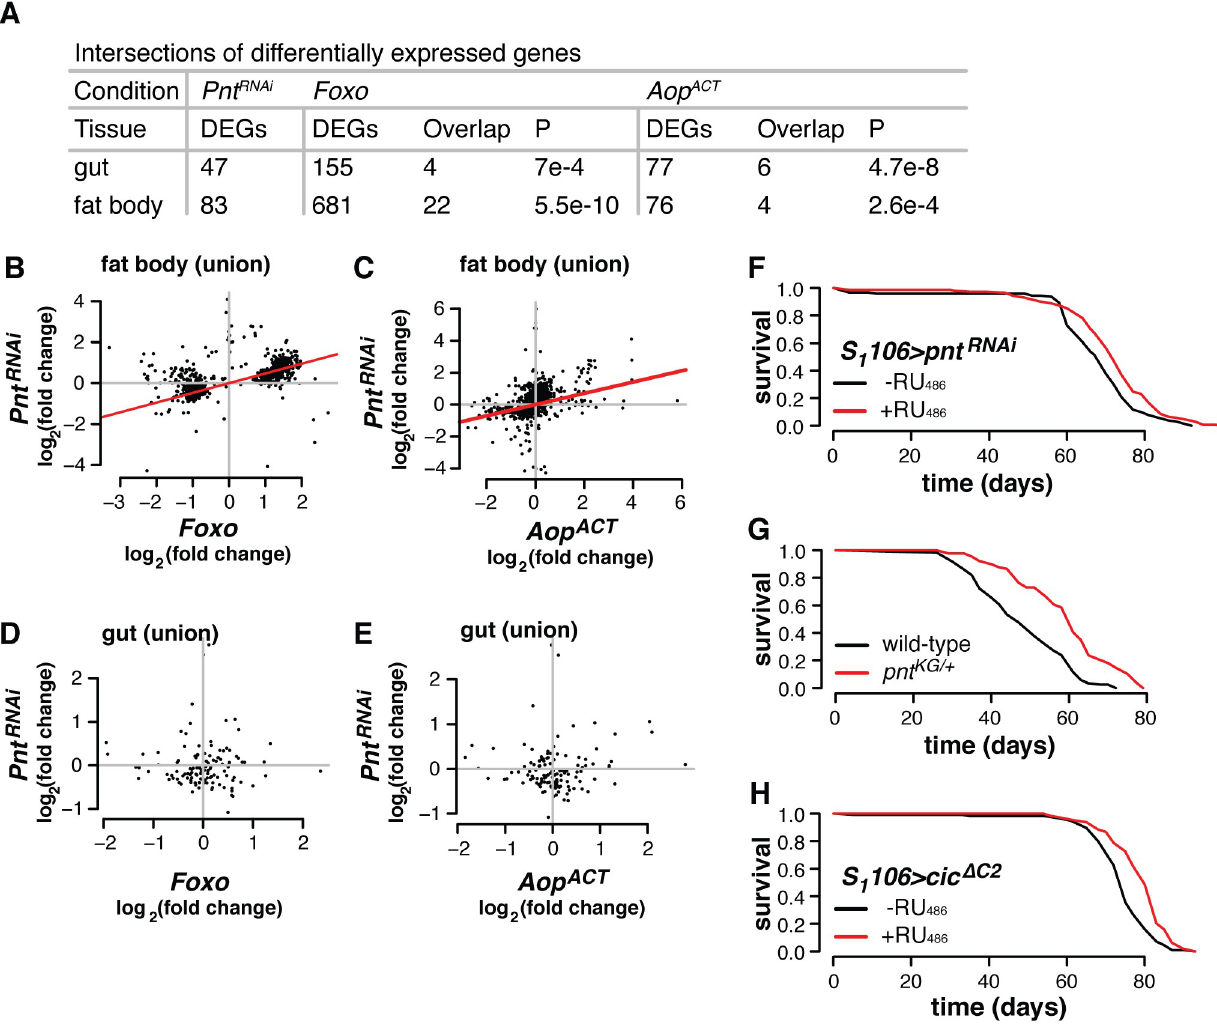
Fig 4. Physiological Pnt regulates lifespan and genes in the Aop/Foxo regulon. (A) Transcriptomic analysis reveals that expressing RNAi against Pnt under control of S 1 06 induces differential expression of set of genes that overlap with the Foxo-Aop regulon, in both gut and fat body. P-values from hypergeometric tests. (B-C) In fat body, in the union of transcripts responding to Pnt RNAi , Foxo or Aop ACT , impacts of Pnt RNAi are correlated to those of Foxo or Aop ACT (log 2 fold-change expression from DESeq2 output). Red lines show correlation coefficients (Kendall’s Tau, P � 2.2e-16 for both tissues). (D-E) . In gut, in the union of transcripts responding to Pnt RNAi , Foxo or Aop ACT , impacts of Pnt RNAi do not correlate those of Foxo or Aop ACT (log 2 fold- change expression from DESeq2 output). (F) Adult-onset Pnt inhibition in the gut and fat body is sufficient to extend lifespan. Log-rank test p = 7.2e-4. (G) Heterozygous Pnt mutants are long-lived. Log-rank test p = 9.2e-11. (H) Overexpressing Cic (an inhibitor of Pnt ), in the gut and fat body extends lifespan. Log-rank test p =